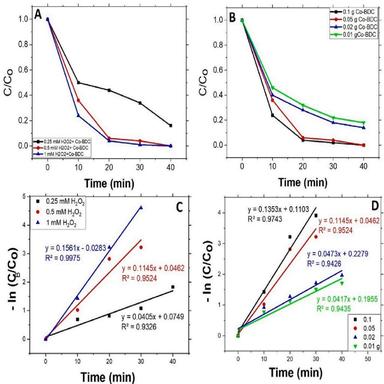
(A) Degradation time profile at different H2O2 concentrations (0.1 g Co-BDC), (B) degradation time profile at different Co-BDC doses (1 mM H2O2), (C) pseudo-first-order plots of MB degradation at different H2O2 concentrations, and (D) pseudo-first-order plots of MB degradation at different Co-BDC doses.